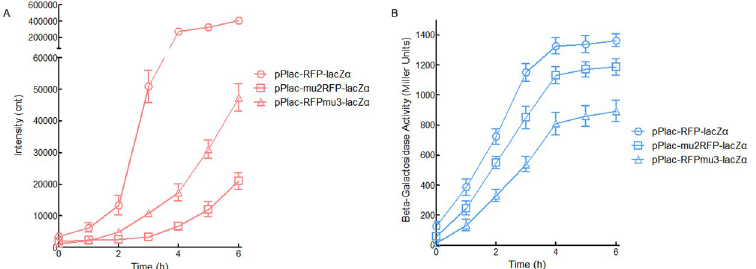
Fig 4. Validation of the dual mCherry-lacZ α reporter system. Top10/pPlac-RFP-lacZ α , Top10/pPlac-mu2RFP- lacZ α , and Top10/pPlac-RFPmu3-lacZ α were exposed to 1.0 mM IPTG at the logarithmic growth phase. The mCherry fluorescence (A) and β -galactosidase activity (B) were determined at different time intervals after 1.0 mM IPTG induction. Data are mean ± SD from three independent assays each from three independent cultivations.